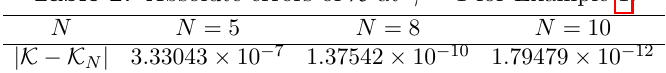
Table 2. Absolute errors of K at γ = 1 for Example 1.